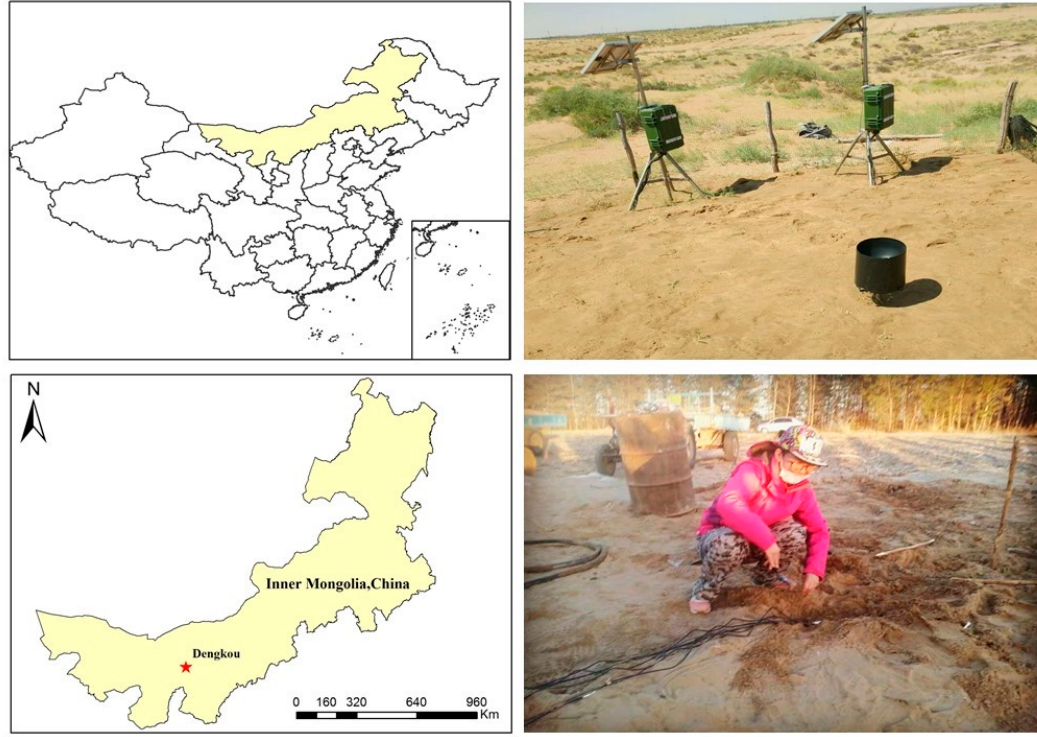
Figure 1. Overview of the experiment plot.